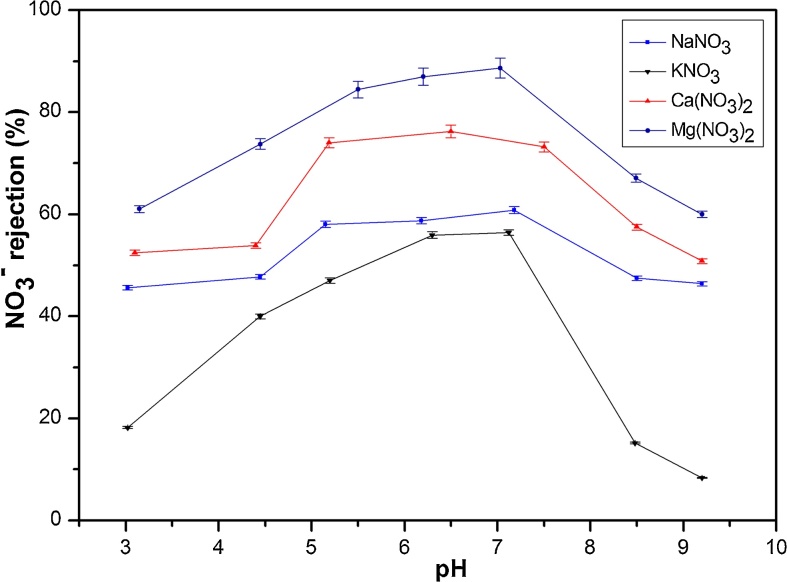
Influence of feed pH on NO3− rejection (%) in binary solutions KNO3, NaNO3, Ca(NO3)2, Mg (NO3)2 at ΔP = 6 bar and Ci = 50 mg(NO3−)/L.